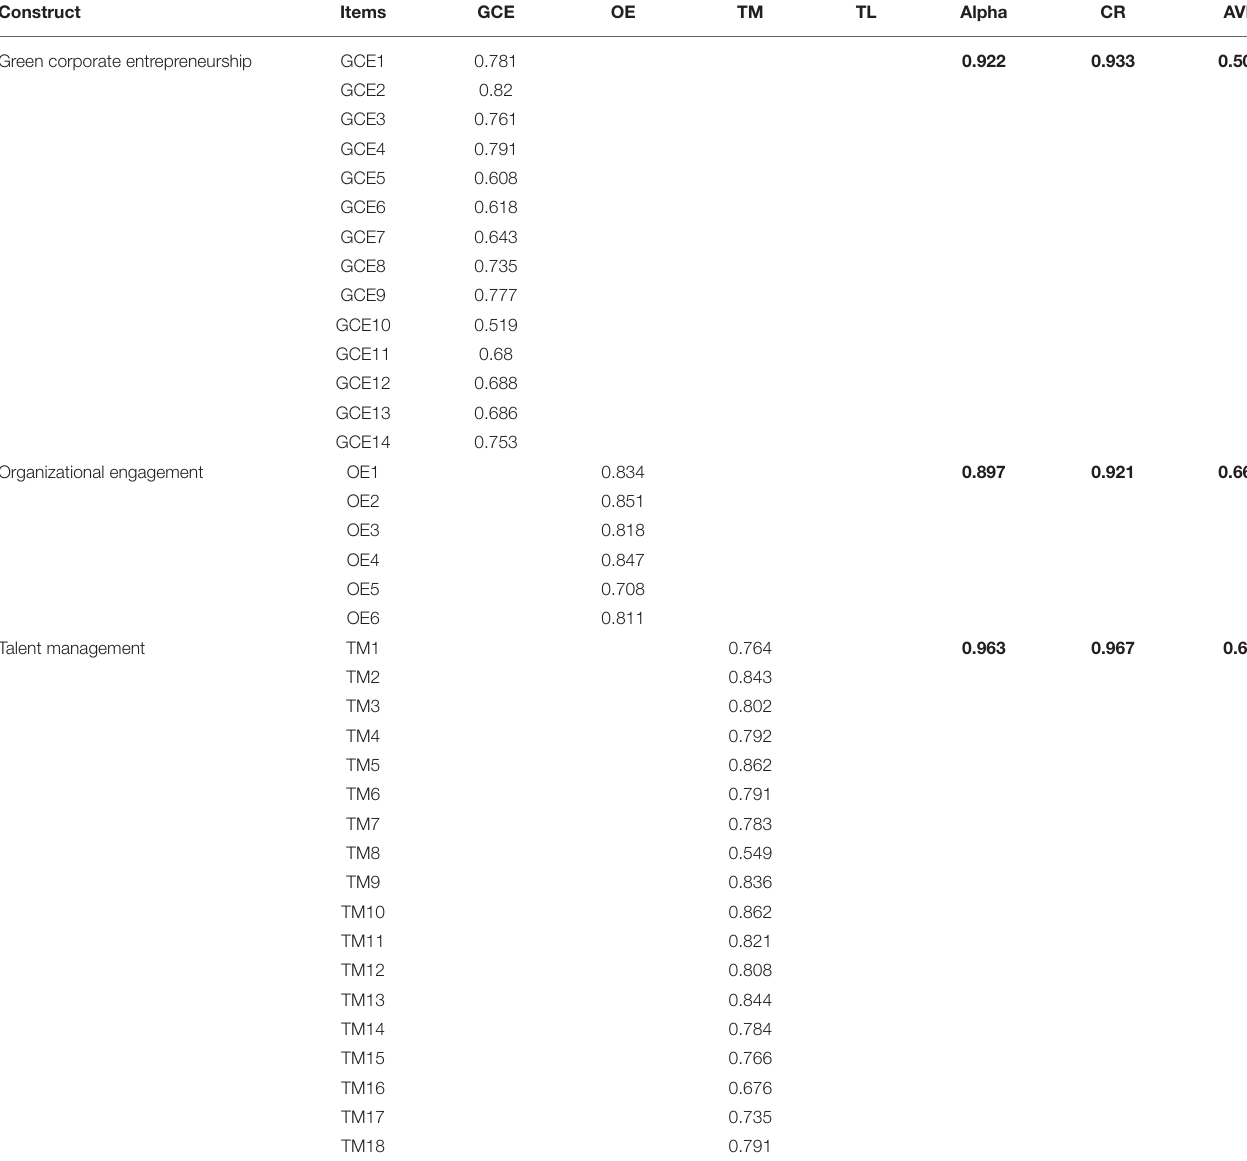
TABLE 2 | Reliability and validity. Construct Items GCE OE TM TL Alpha CR AVE Green corporate